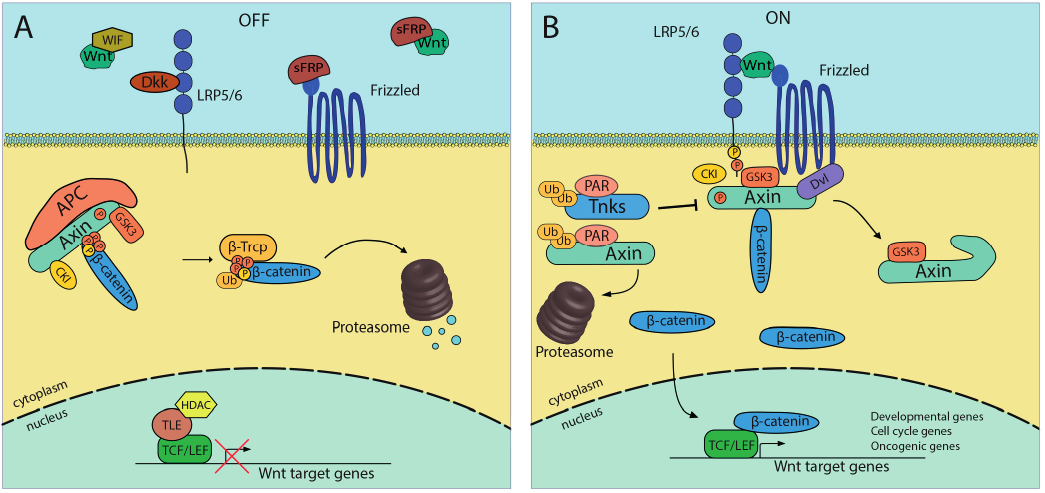
Figure 1. Wnt/ β -catenin signaling pathway. ( A ) In absense of Wnt; ( B ) after binding of Wnt-ligand. APC, adenomatous poyposis coli; CK1, casein kinase1; Dkk, dickkopf; Dvl, disheveled; β -Trcp, beta-transducin repeat containing; GSK3, glycogen synthase kinase 3; LRP 5/6, LDL receptor-related protein 5/6; TCF, T cell factor. From APC: FRP, frizzled related protein; WIF, Wnt inhibitor factor; HDAC, histone deacetylase; Tnks, tankyrases; LEF, lymphoid enhancer-binding fator; PAR, poly (ADP-ribose); TLE, transducin-like enhancer